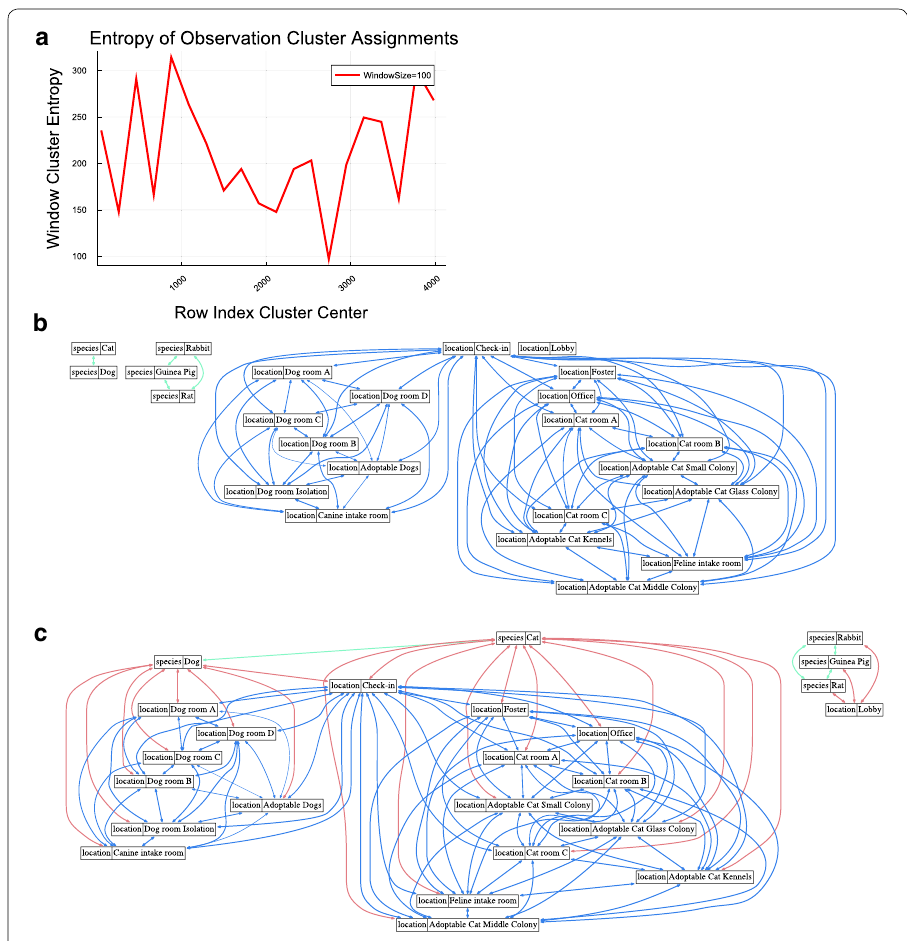
Fig. 1 The results of the methodology applied to data of a pet shelter; 2017 Bloomington Animal Shelter (from data.gov ). Two variables (columns) are chosen from the data; the ‘species’ and ‘location’. a Shows the cluster entropy value changes along the event data for subsetting upon a window length shown in the legend. b Shows the number of walks of length 2 between label values within a column (the triangulation edges). This produces a separate network diagram for each variable where edges show that two labels have been in an event where another variable(s) was recorded with the same label, and the width is proportional to those counts. c Shows the network with edges of walk length 2 (triangulation) and walk 1 which is the even variable label co-occurrence